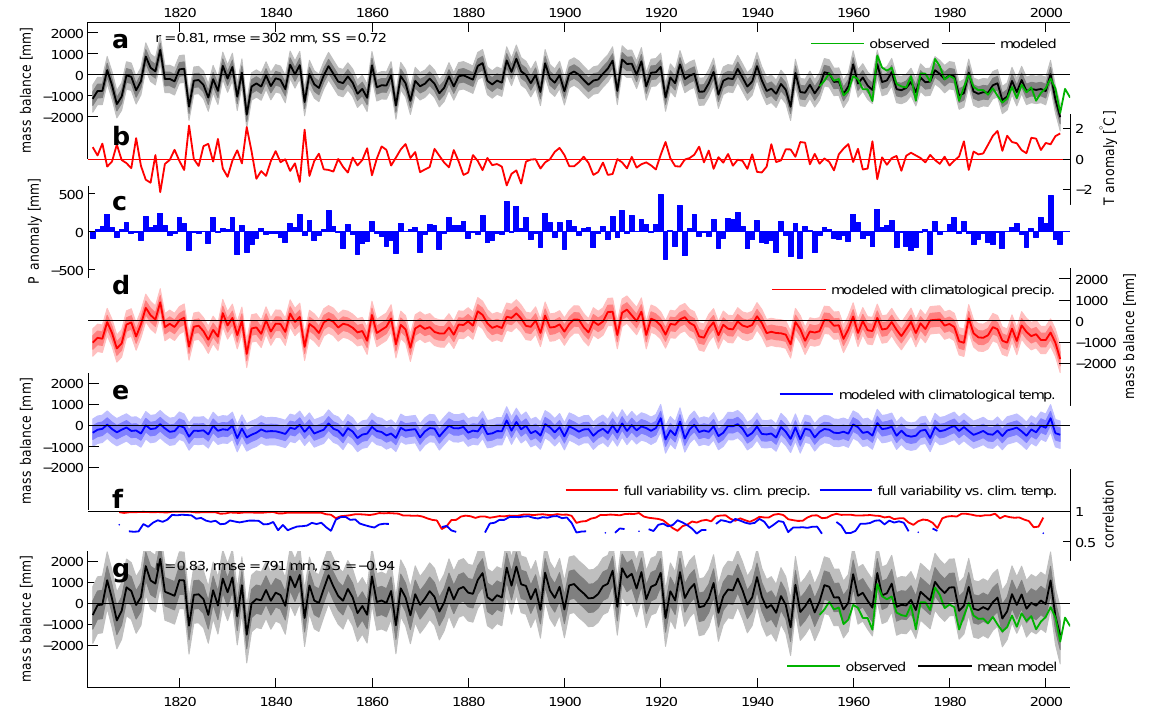
full variability vs. clim. precip. full variability vs. clim. temp.